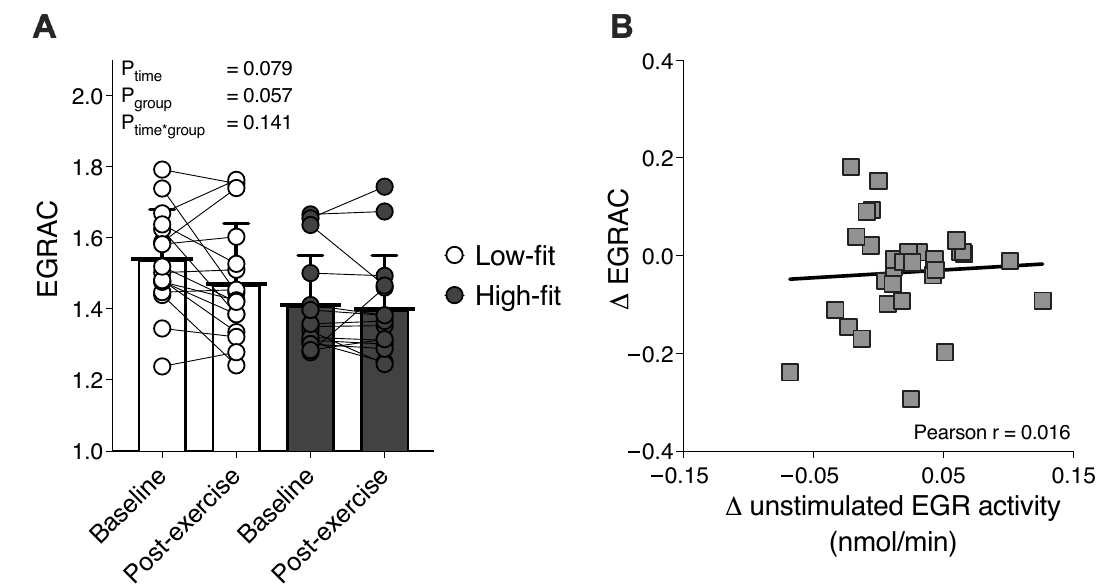
Figure 2. The effect of a single exercise bout on vitamin B2 status (EGRAC) in high-fit and low-fit females. Baseline and post-exercise EGRAC in low-fit (N = 16, white) and high-fit (N = 15, grey) females ( A ). Correlation between the individual exercise response of unstimulated EGR activity ( ∆ unstimulated EGR activity, expressed as nmol NADPH per minute) and the exercise response of EGRAC ( ∆ EGRAC); the high-fit and low-fit groups are plotted together ( B